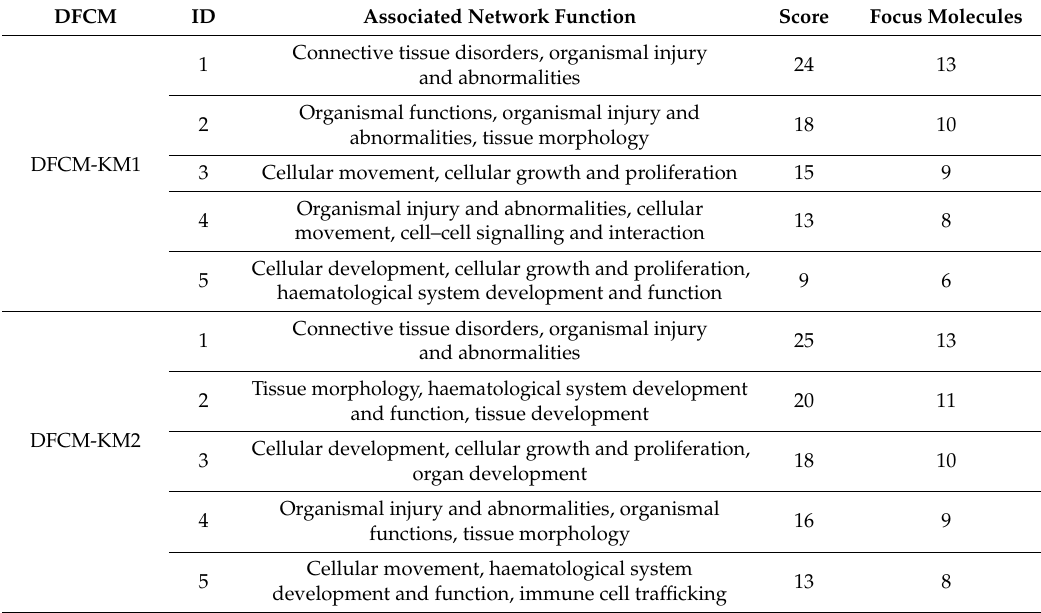
Table 4. Networks generated by pathway interaction